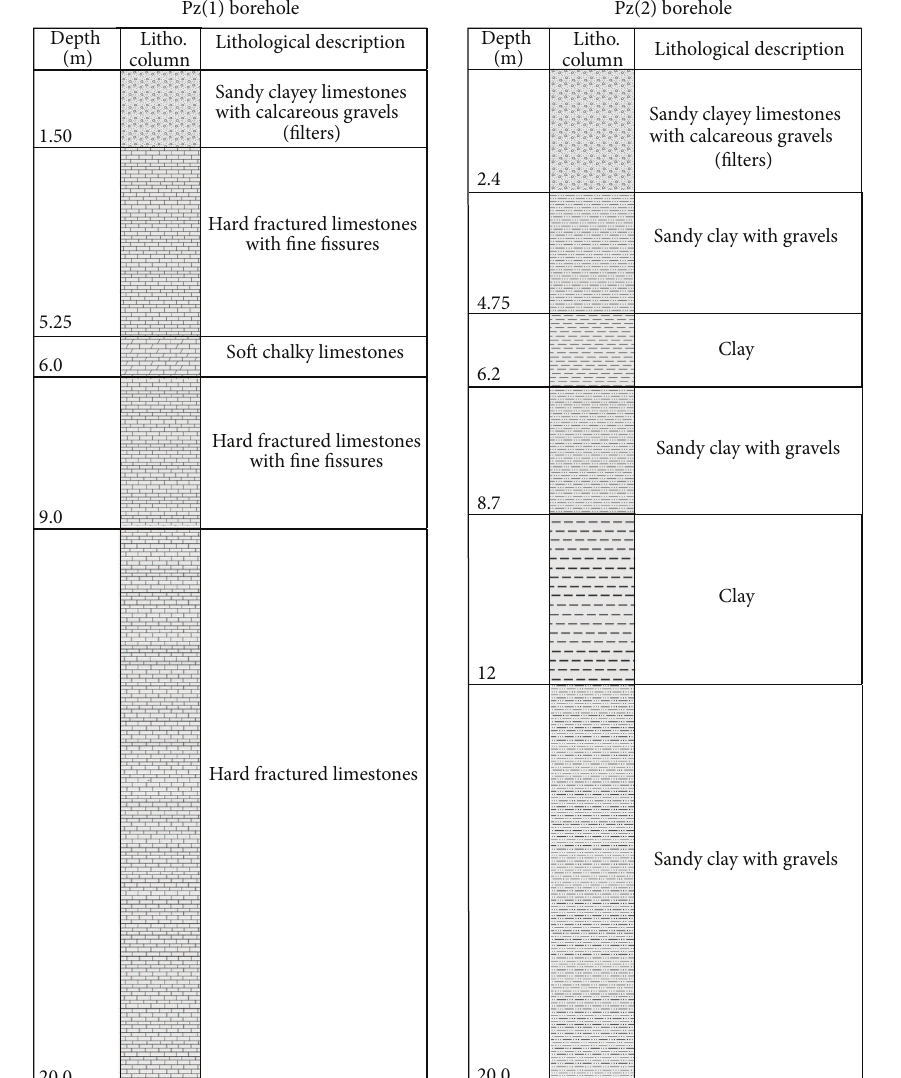
activity responsible for faulting and subsiding. From geo- logical and tectonic point of view, block II forms a 200